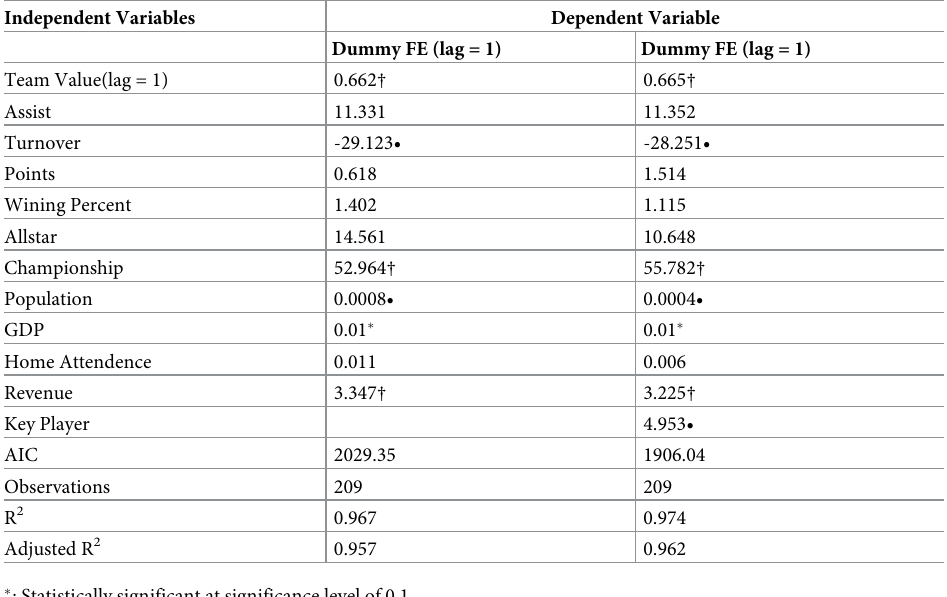
Table 6. Comparison of fixed effects